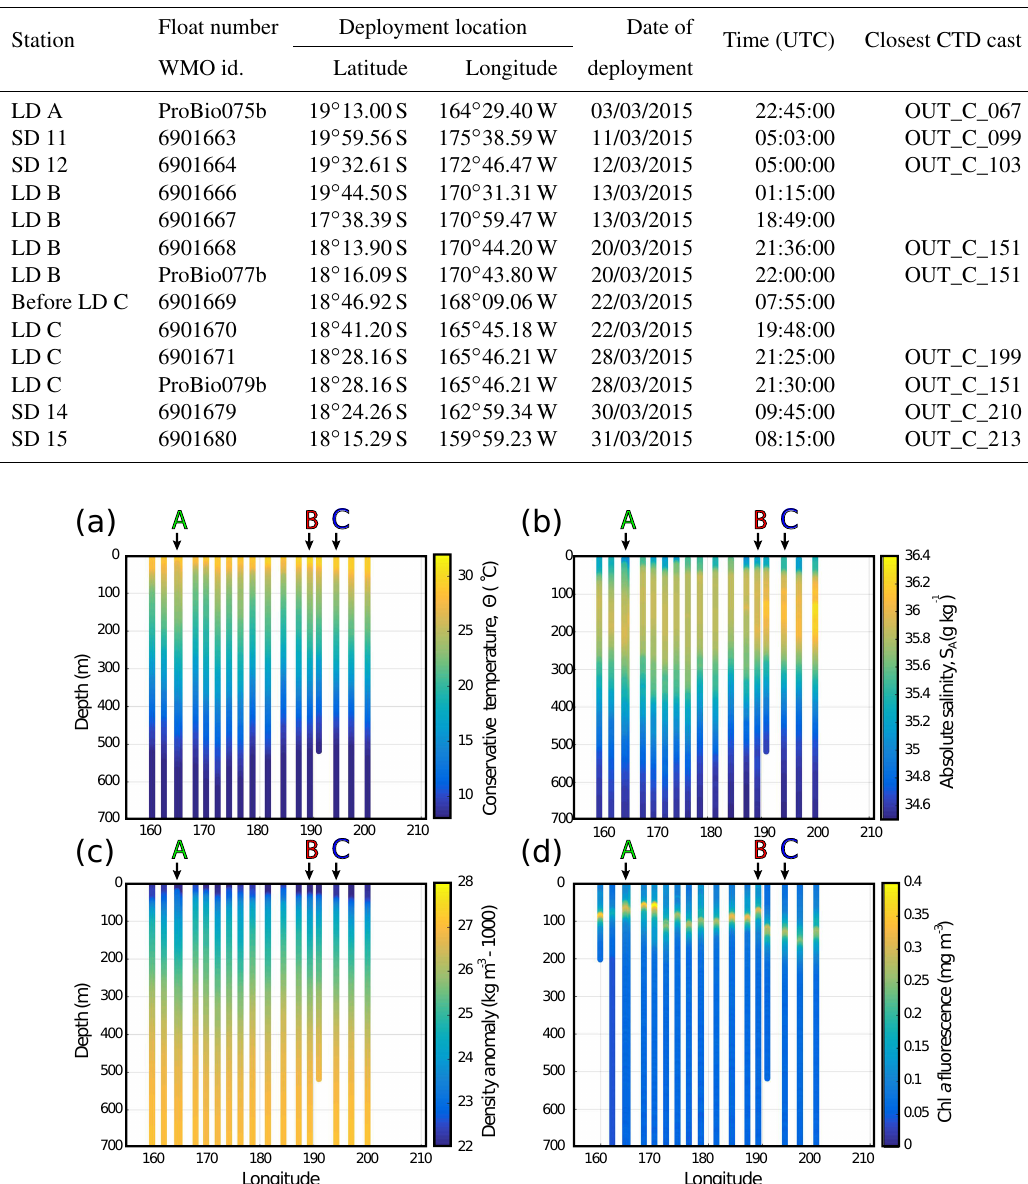
Table 2. PROVOR Argo floats deployed along the OUTPACE transect. Station